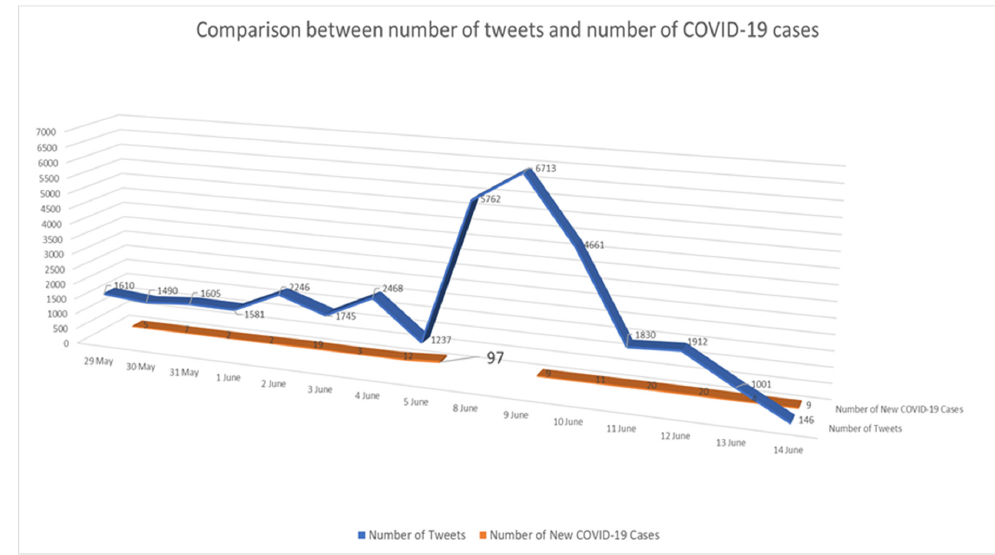
Figure 2. Overall volume of tweets and new COVID-19